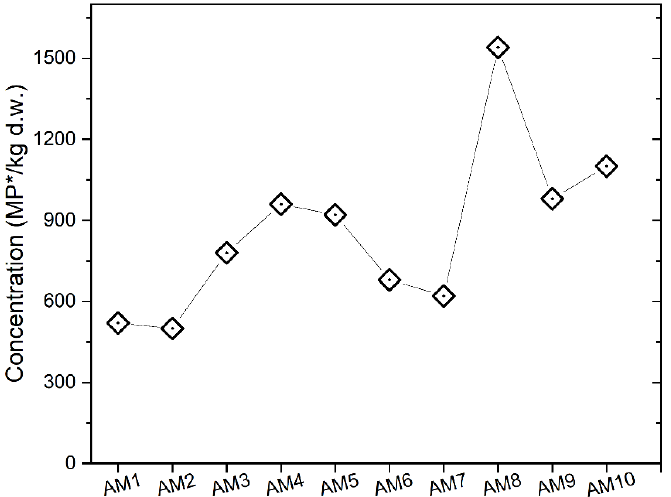
Figure 5. Contents of MP* (MP*/kg d.w.) in sediments of the MC at the AM1–AM10 sampling sites.